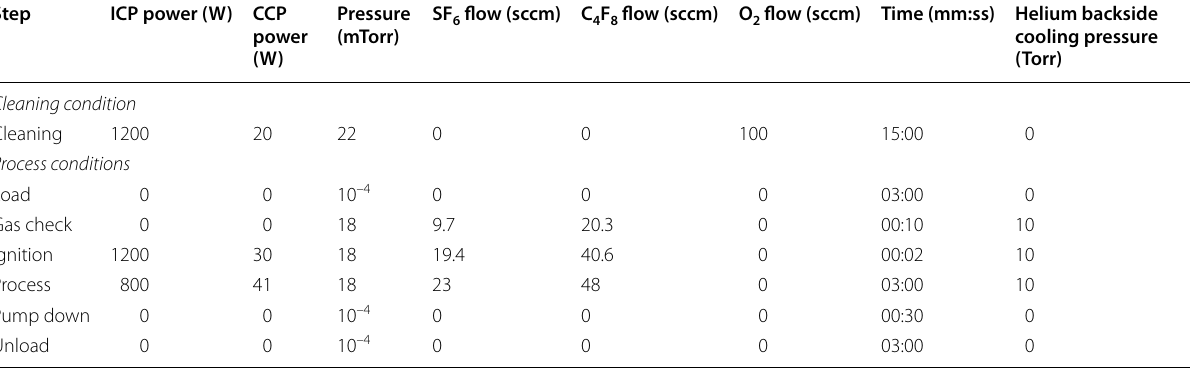
Table 1 List of settings used on the Plasma Pro system to condition the cleaning and perform the etching steps